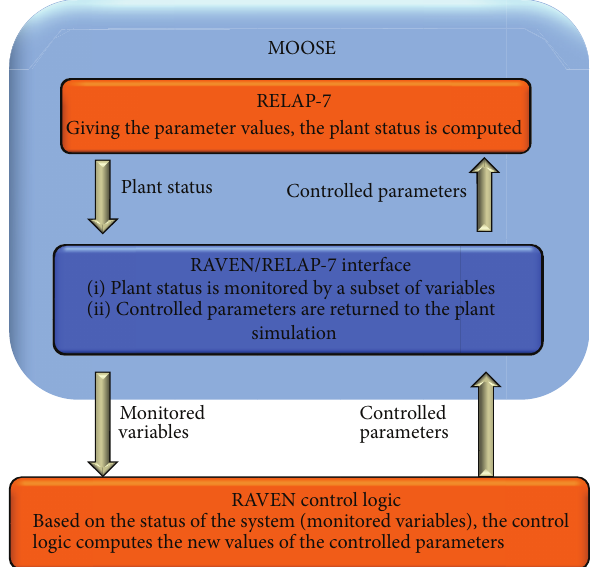
Figure 3: RAVEN simulation controller